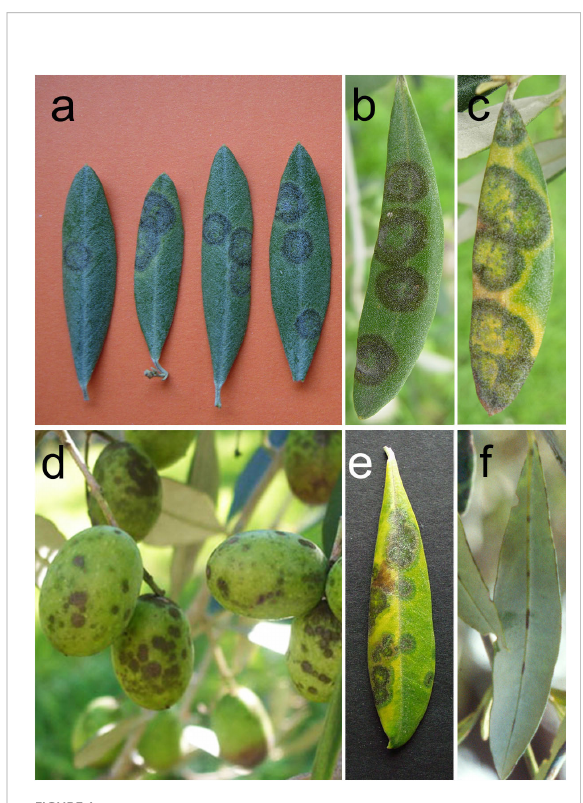
FIGURE 1 Symptomsand signs caused by Venturia oleaginea in olive trees. (A) circular spots uniformly coloured in browngreen onupperleaf surface; (B) concentric ringswhichareolive-green, grey,dark brown from centerto periphery onupper leaf surface; (C) yellow haloes surrounding the leaf spots; (D) brownvelvety spots onolive drupes; (E) green islands surrounding the leaf spots; (F) dark brown streaks onthe main vein of the lowerleaf